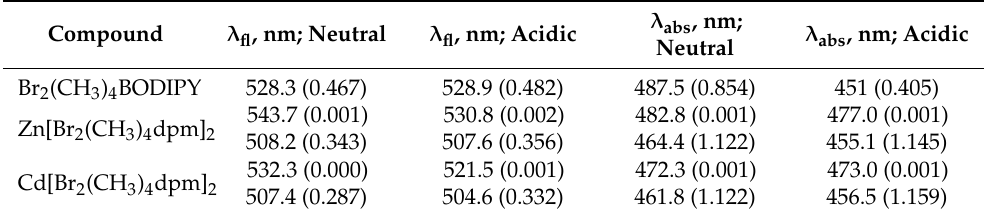
Table 2. Absorption ( λ abs ) and fluorescence ( λ fl ) wave-lengths with oscillator strengths (in parenthe- ses) of the compounds in ethanol solvent neutral and acidified states using hydrogen chloride (acidic).